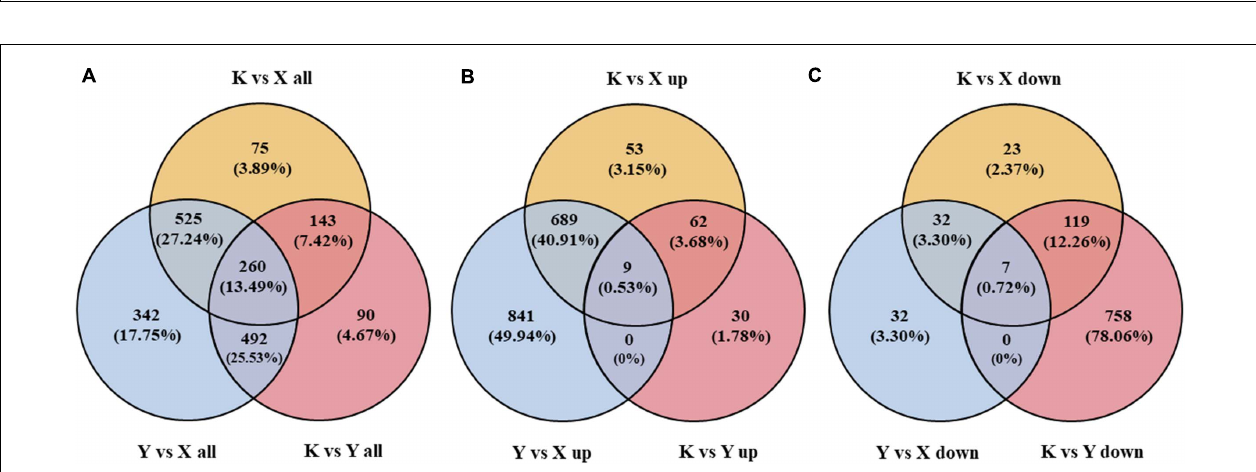
FIGURE 4 | Venn diagram of DAPs identified from different comparisons in rhubarb samples. (A) Venn diagram of all the DAPs identified in rhubarb samples; (B) Venn diagram of the up-regulated proteins identified in rhubarb samples; (C) Venn diagram of the down-regulated proteins identified in rhubarb samples.